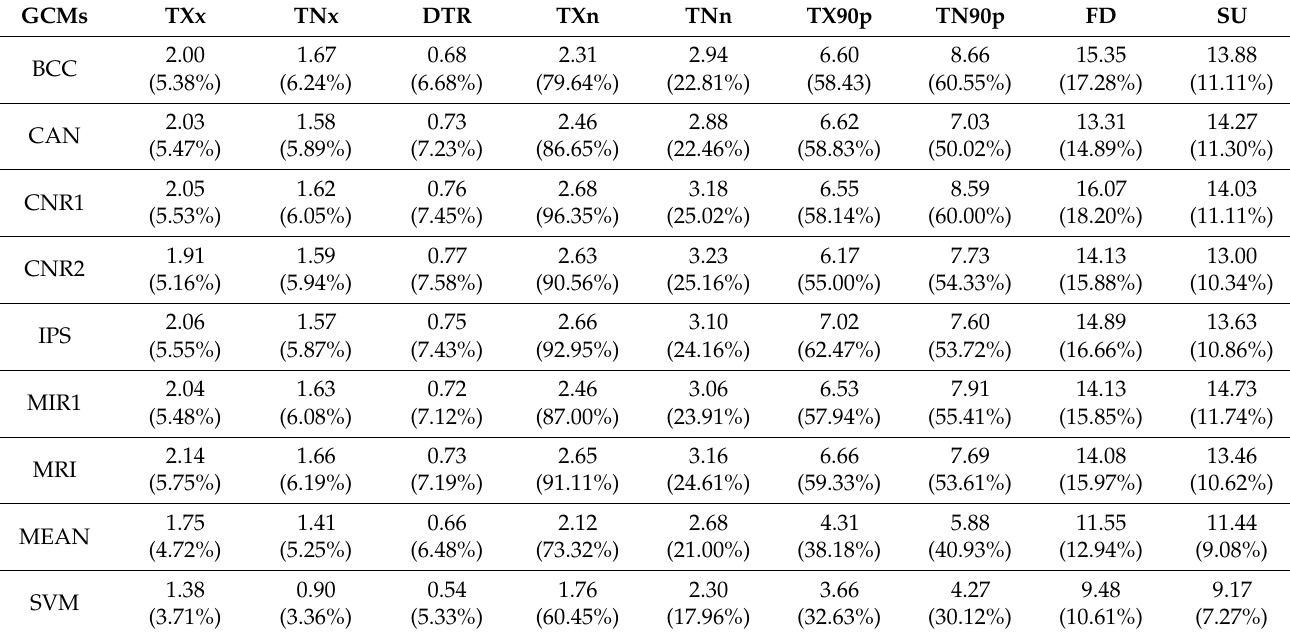
Table 3. Root mean square error (RMSE) and relative standard deviation (RSD) between simulations and observed values for the nine extreme temperature indices.